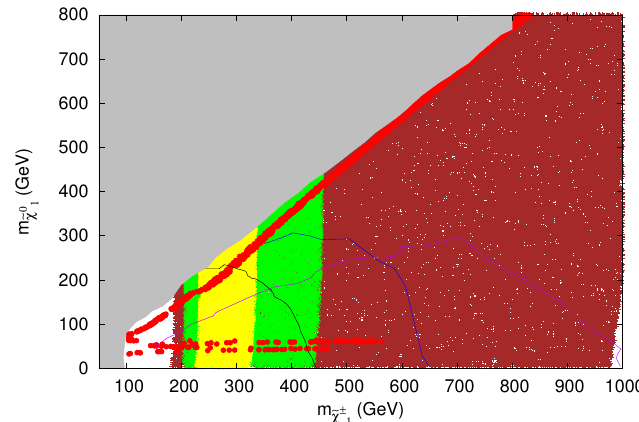
Figure 6 . Exclusion contours in the m (LHLS) model. The blue (black) line represents exclusion obtained by us ([10]) using the ATLAS 3 l + E= T search data from Run II (Run I). The exclusion from the direct slepton search (the magenta curve) is also shown. Colors and conventions are same as in (cid:12)gure 1.